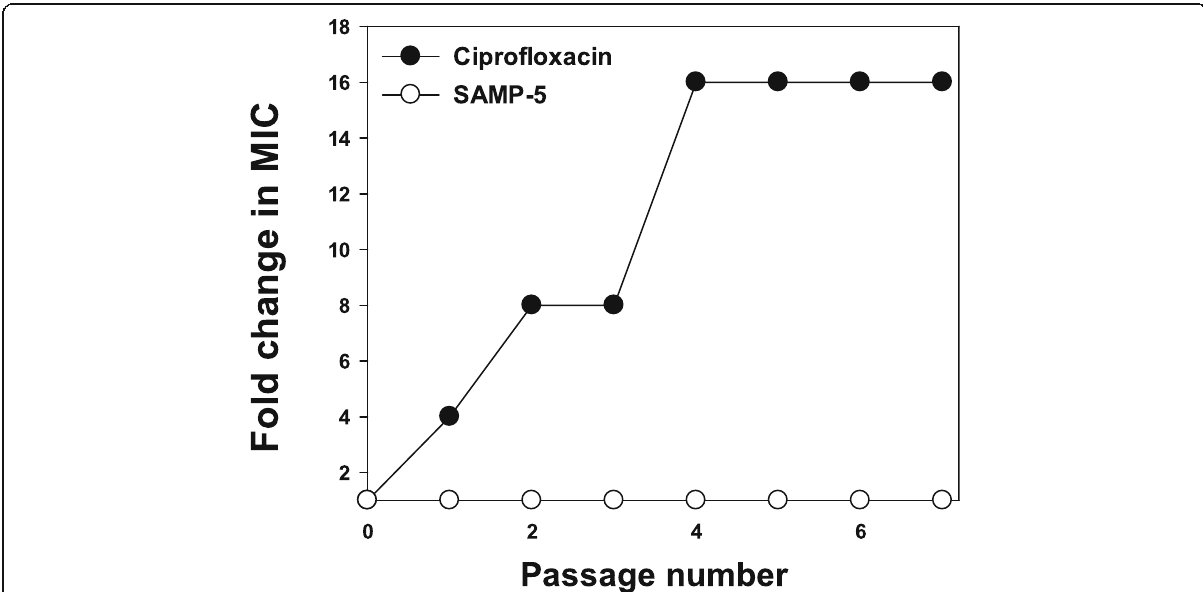
Fig. 4 Antibiotic resistance development of Pseudomonas aeruginosa (KCTC 1637) in the presence of sub-MIC (0.5 × MIC) concentration of SAMP- 5 and